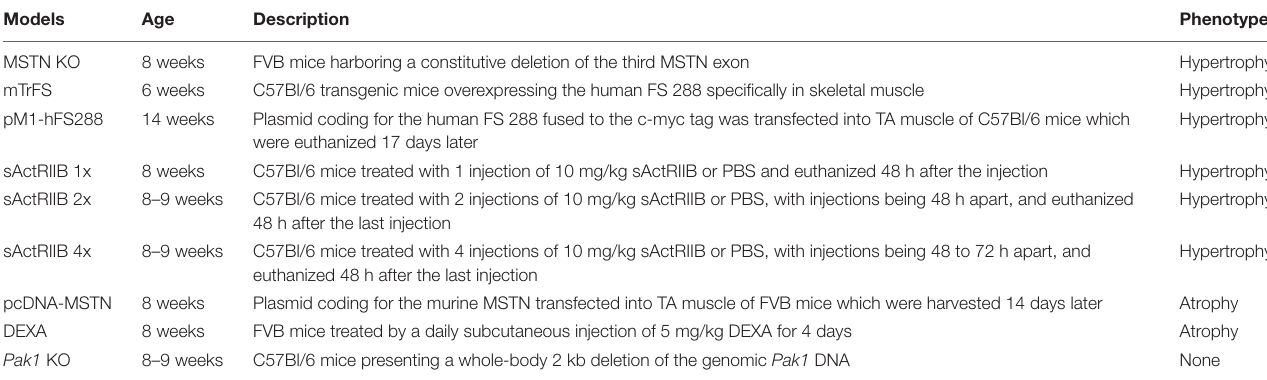
TABLE 1 | Overview of the different animal